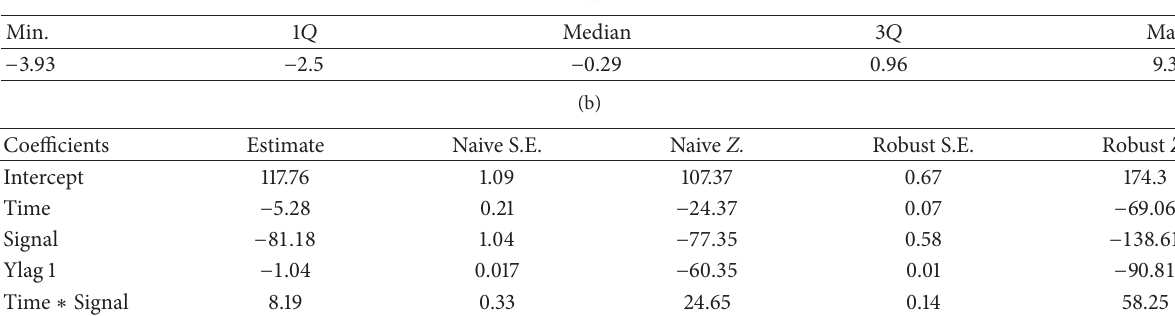
Table 10: The residuals and coefficients for transitional